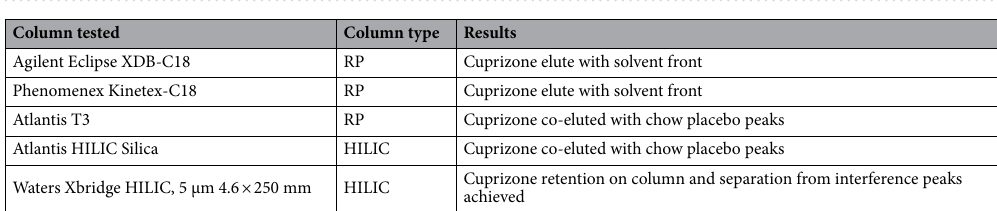
Table 4. Summary of the columns screened for the method development.